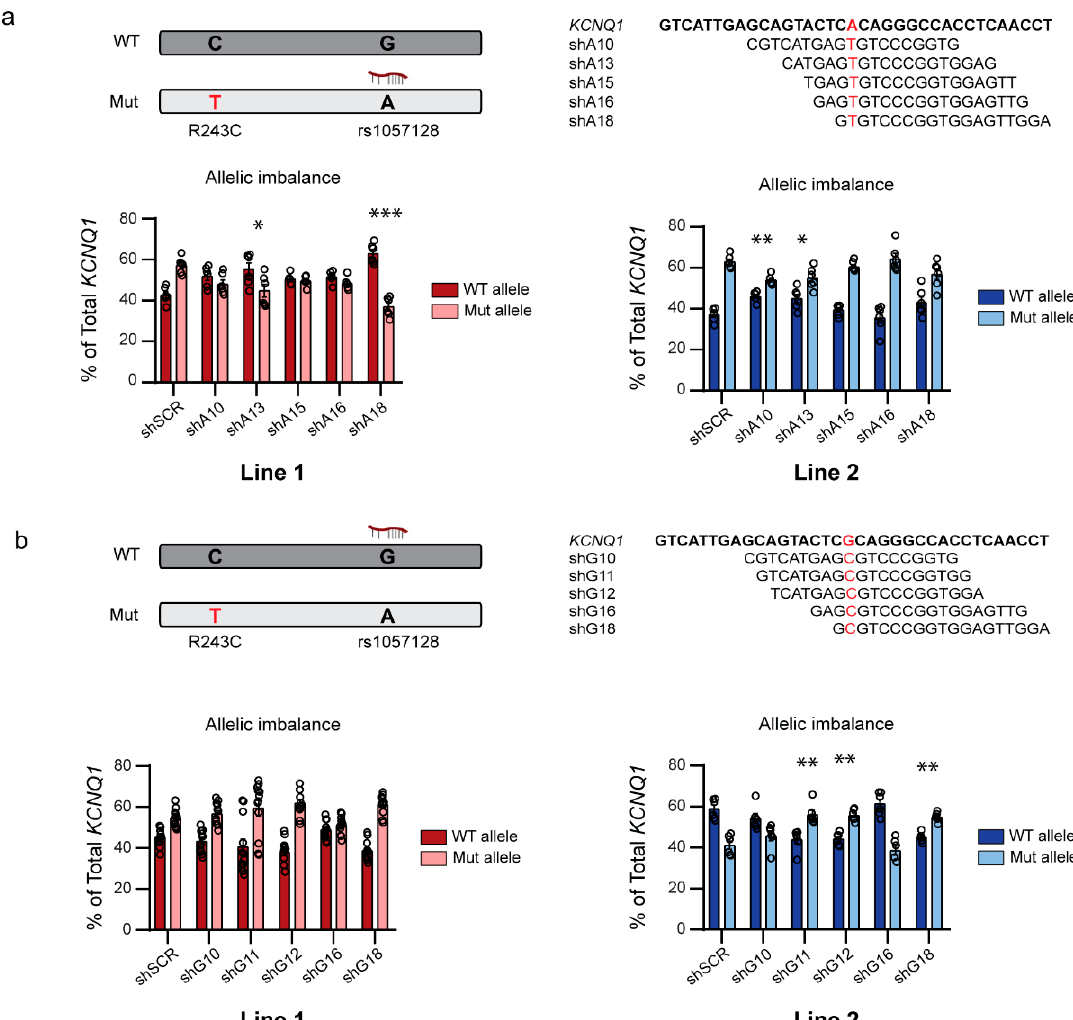
Figure 2. Allelic imbalance induced by allele-specific shRNAs: ( a ) Top, schematic representation of the shRNAs targeting the mutant KCNQ1 allele in hiPSC-CMs. Bottom, allelic expression of wild-type and mutant KCNQ1 allele presented as % of total KCNQ1 expression for Line 1 in red (left; n = 6) and Line 2 in blue (right; n = 6); ( b ) Top, schematic representation of the shRNAs targeting the wild-type KCNQ1 allele. Bottom, allelic expression of wild-type and mutant KCNQ1 allele presented as % of total KCNQ1 expression for Line 1 in red (left; n = 12) and Line 2 in blue (right; n = 6). * p < 0.05; ** p < 0.025; *** p < 0.001 compared to allelic expression in the shSCR negative control shRNA; error bars indicate SEM.